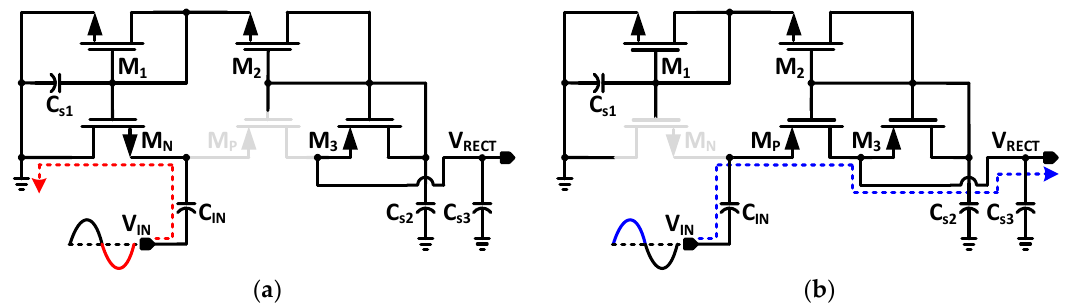
Figure 7. Working principle of the proposed rectifier. ( a ) Charging phase; and ( b ) discharging phase.